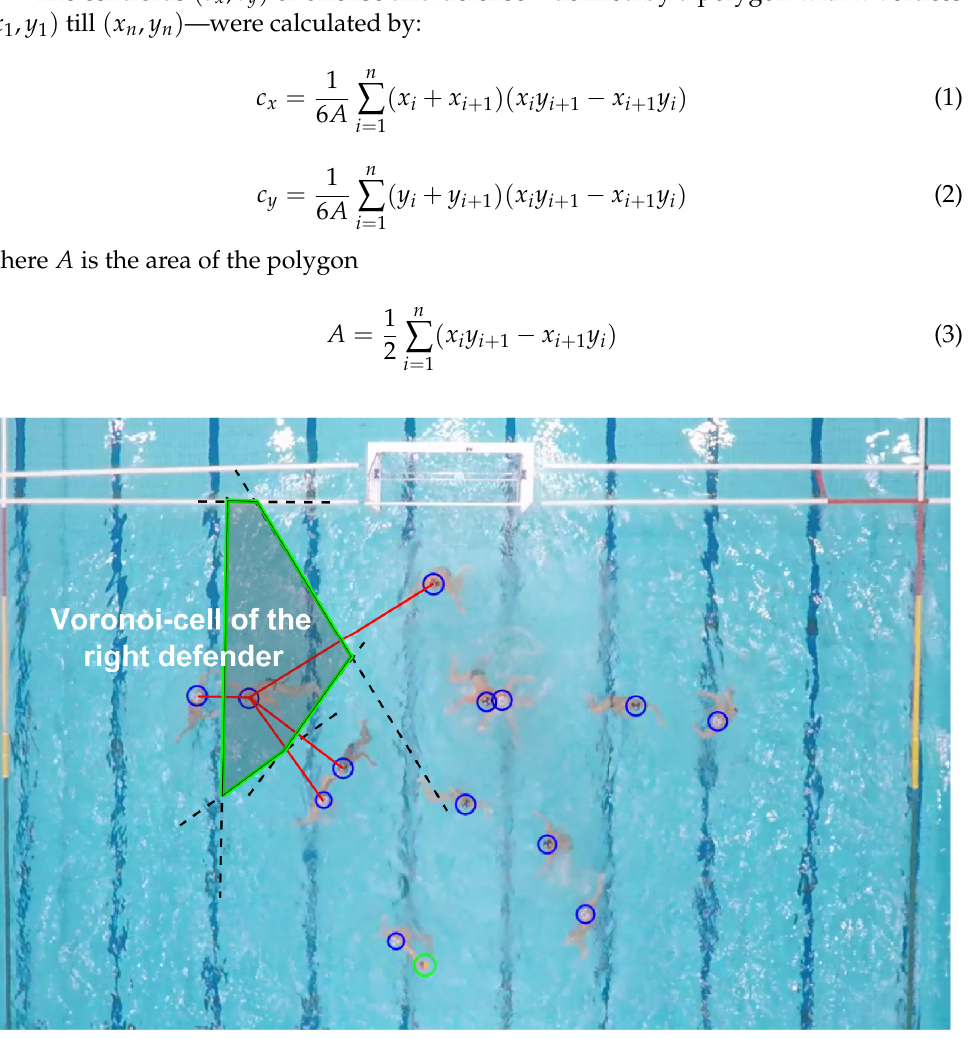
Figure 3. Definition of the Voronoi-cells exemplary for the right defender. The red lines represent the connection line between both players. The borders are the dashed black lines which are perpendicular to the red connection lines at the half distance between two players. The intersection of all these boundary lines (black dashes lines) or the boundary of the field creates the Voronoi-cell (delimited by the green line) associated with the player